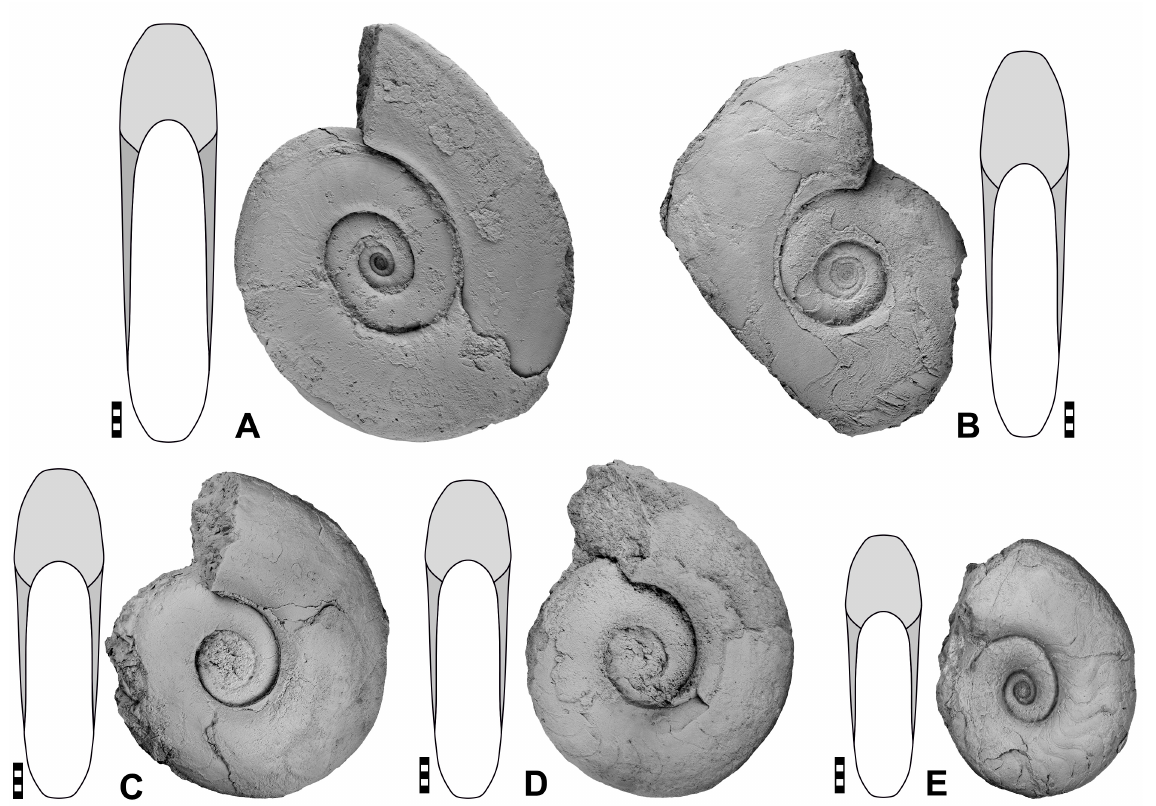
Fig. 5. Pseudoprobeloceras pernai (Wedekind, 1918). A . Specimen MB.C.30418, probably